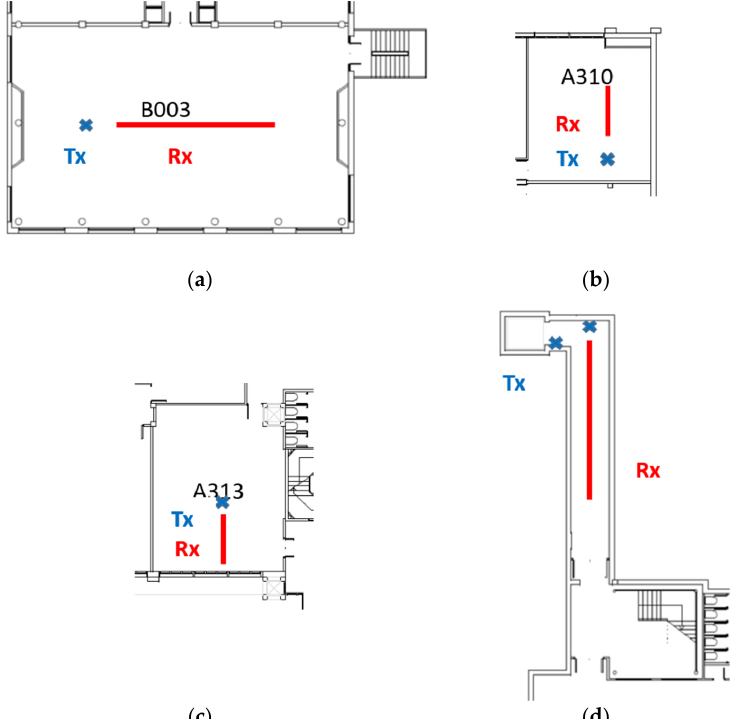
Figure 2. Environment schemes for measurements in the 3 GHz band ( a ) auditorium; ( b ) small lab #1; ( c ) small lab #2; and ( d ) corridor.